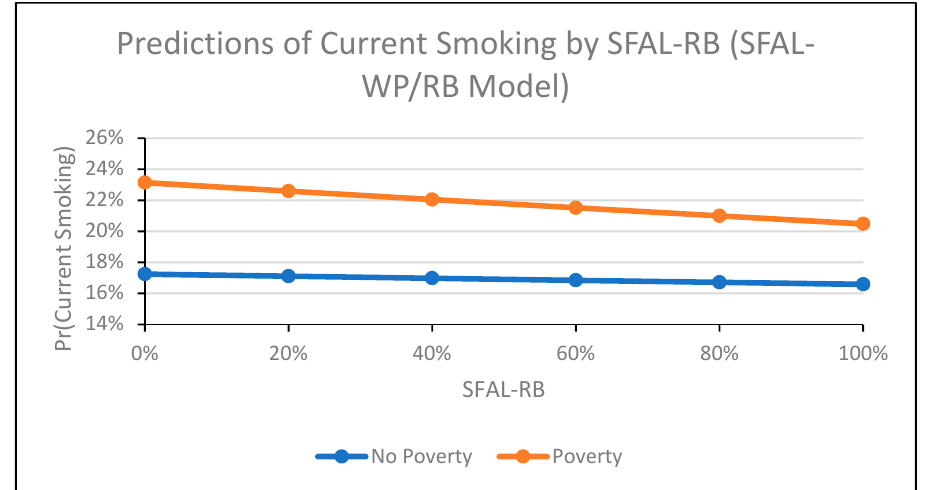
Figure 4. This figure depicts the probability of individual-level adult current smoking in the 1985 − 2015 supplements to the U.S. Current Population Survey by percent of state population covered by restaurant and / or bar smoke-free laws, stratified by poverty status (living < 138% of poverty line versus living ≥ 138% of poverty line). Smoke-free law coverage is modeled as the percent of state population covered by workplace laws and percent covered by restaurant and / or bar laws, and the figure excludes participants with missing values for variables of interest. The figure was produced using the “margins” command in Stata.